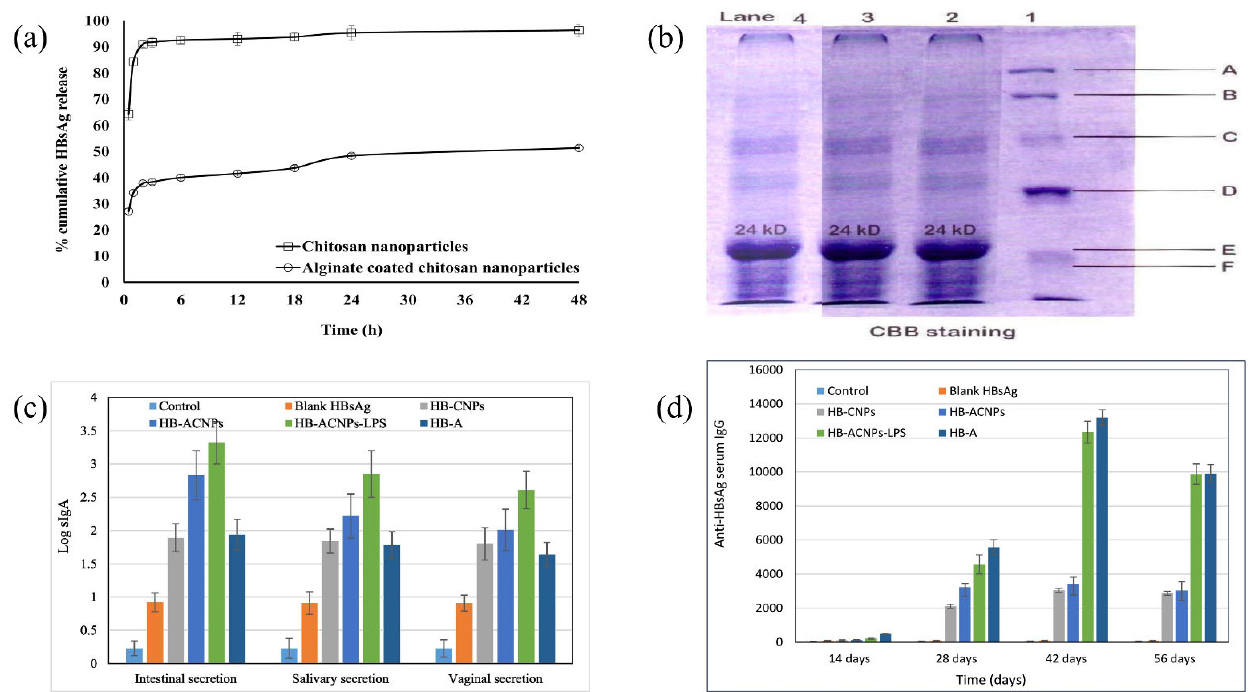
Figure 9. Lipopolysaccharide-derived ALG coated Hepatitis B antigen-loaded CS nanoparticles for oral mucosal immunization ( a ) Release profile of produced nanoparticles in vitro. ( b ) HBsAg release as determined by SDS-PAGE: Lane 1: Molecular weight markers; Lane 2: HBsAg solution; Lane 3: HBsAg loaded CS nanoparticles, Lane 4: HBsAg-loaded ALG coated CS nanoparticles produced from LPS. ( c ) The levels of sIgA in the fluid secretions of mice immunized with different formulations. ( d ) Anti-HBsAg IgG levels in mice inoculated orally with various formulations. Reproduced with permission from [270], Copyright Elsevier, 2020.